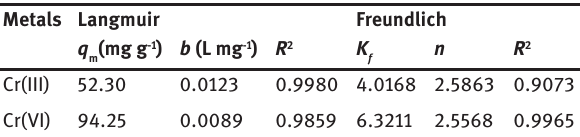
Table 1: Langmuir and Freundlich parameters of Cr(III) and Cr(VI) adsorption on